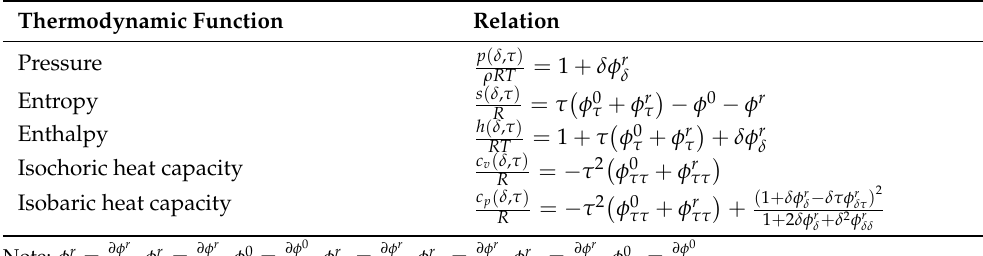
Isochoric heat capacity Isobaric heat